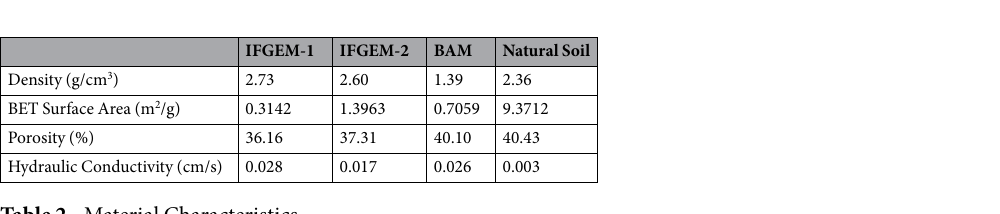
Table 2. Material